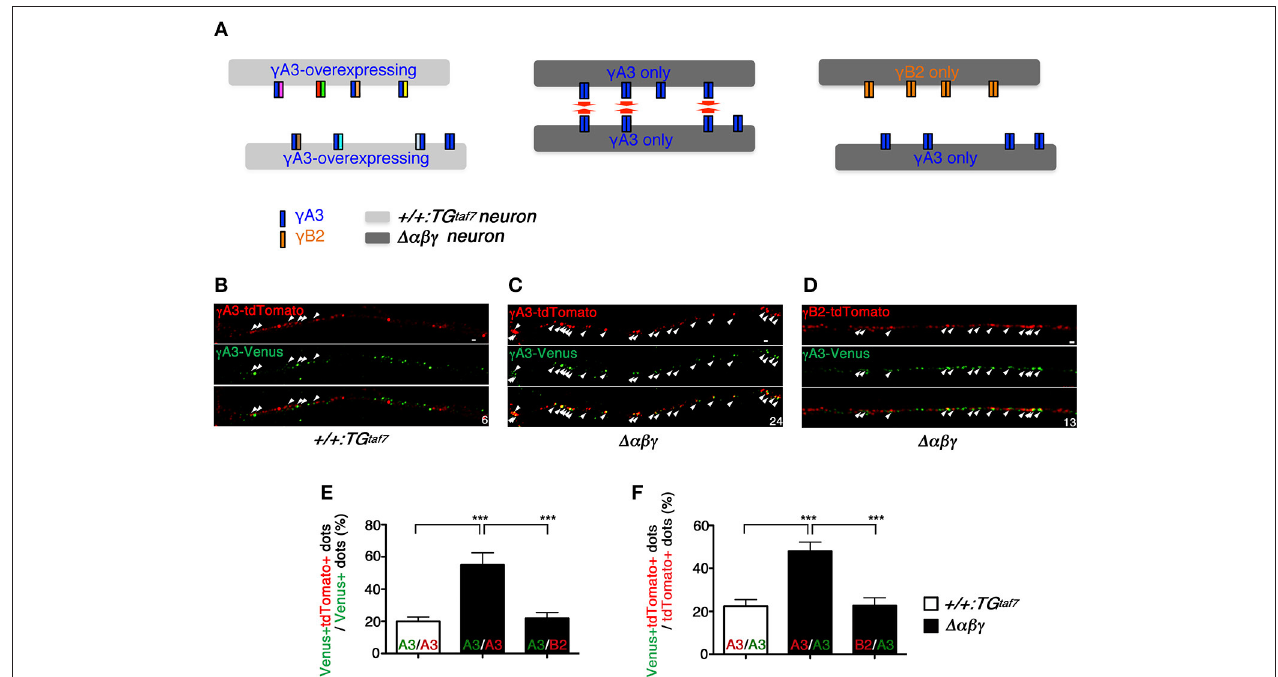
FIGURE 6 | Pcdh single-isoform overexpression in dissociated neurons revealed exclusively homophilic neuron–neuron interactions in trans. (A) Schematic diagram of the highly frequent trans -homophilic interactions of the γ A3 isoforms between ∆αβγ neurons. To simplify the demonstration, each isoform complex is shown as a dimer. (B,C,E,F) E16.5 hippocampal neurons were nucleofected with γ A3-tdTomato or γ A3-Venus expression vectors and co-cultured for 11 days. Significantly more tdTomato + and Venus + dots were colocalized in the hippocampal neurons of ∆αβγ mutants, compared to those of the + / + :TG taf 7 mice. The small numbers at the corners indicate the number of colocalized yellow dots (arrows). (D) A similar experiment with different Pcdh isoforms ( γ B2-tdTomato and γ A3-Venus) in ∆αβγ mutants showed that the homophilic interaction was an isoform-specific feature that was only detectable in the ∆αβγ neurons. Immunostaining revealed microscope fields in which tdTomato + and Venus + neurites ran parallel within a distance of < 0.5 µ m of each other. Data were analyzed by one-way ANOVA and post-hoc Tukey tests. The numbers of neurite pairs analyzed were as follows: γ A3- γ A3, 11 control ( + / + :TG taf 7 ) and 16 ∆αβγ ; γ A3- γ B2, 20 in mutant ∆αβγ . Error bars represent SEM; *** P < 0.001. Bars: 0.5 µ